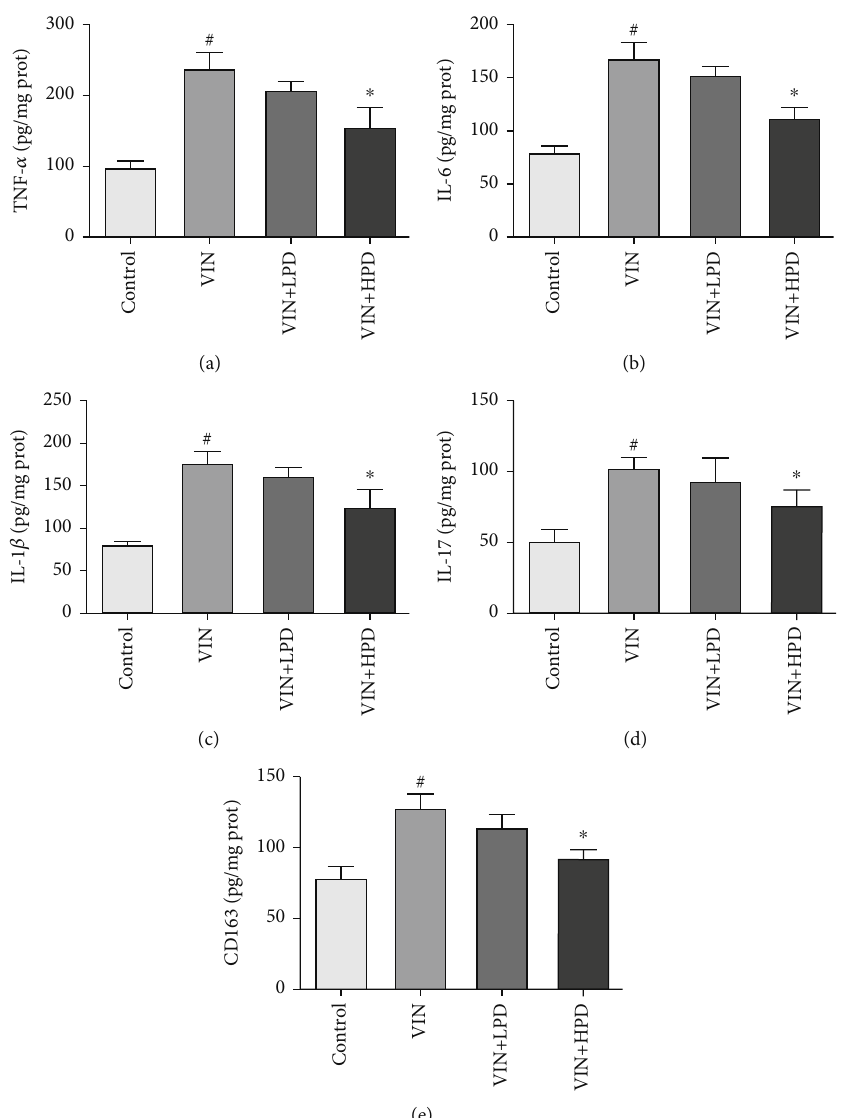
Figure 7: E ff ect of polydatin on in fl ammatory cytokines and macrophage marker in VIN-induced rats. The levels of TNF- α (a), IL-6 (b), IL- 1 β (c), IL-17 (d), and CD163 (e) in the dorsal root ganglion were measured by ELISA kits. Results were expressed as mean ± SD ( n = 6 ). # P < 0 : 05 , the VIN group compared with the control group; ∗ P < 0 : 05 , the VIN+HPD group compared with the VIN-treated